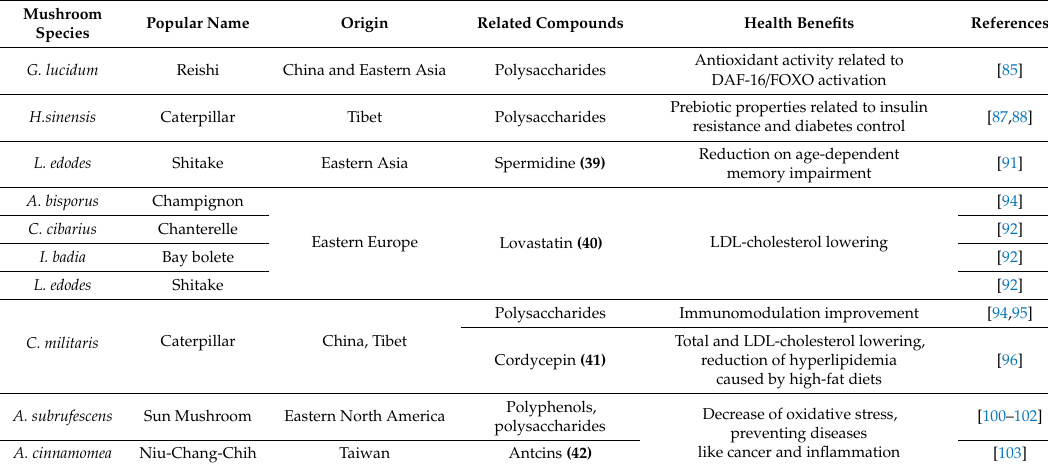
Table 5. Mushroom-originated compounds and health benefits related to non-transmissible chronic diseases